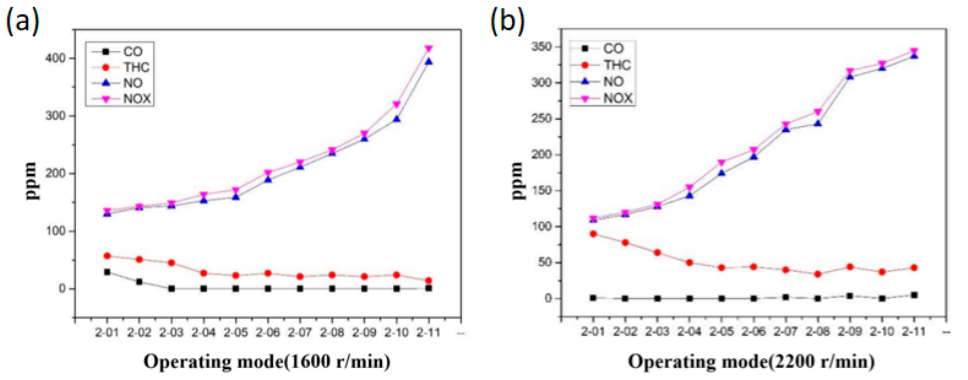
Figure 3. Physical diagram of the two pollutant analyzers. ( a ) AVL DICOM 4000 pollutant analyzer. ( b ) HORIBA MEXA-7100DEGR pollutant analyzer.